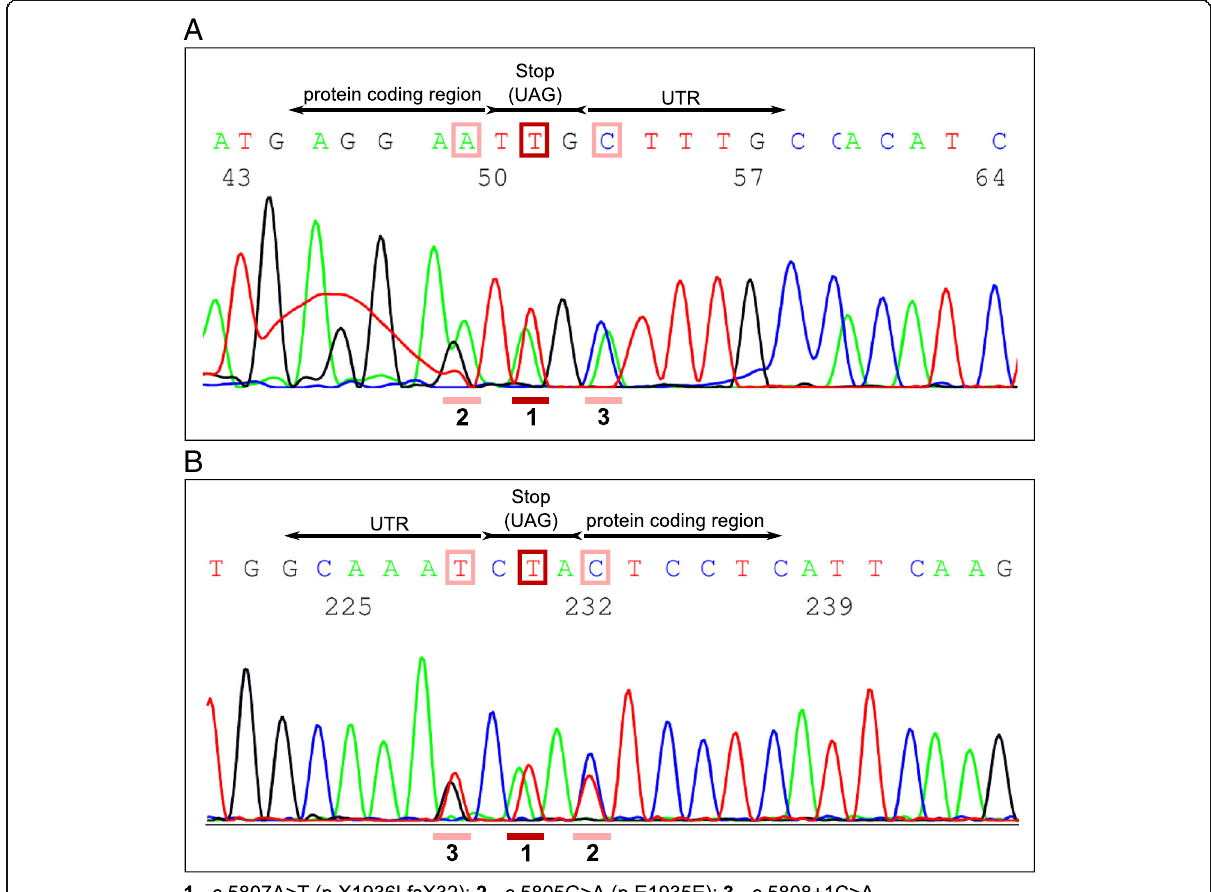
Fig. 4 Electropherogram of the involved sequence fragment of MYH7. The result of forward sequencing ( a ). The result of reverse sequencing ( b ). The detected mutation and the two variations c.5805G > A, c.5807A > T and c.5808 + 1C > A are highlighted with rectangles in the nucleotide sequence and corresponding peaks are also underlined